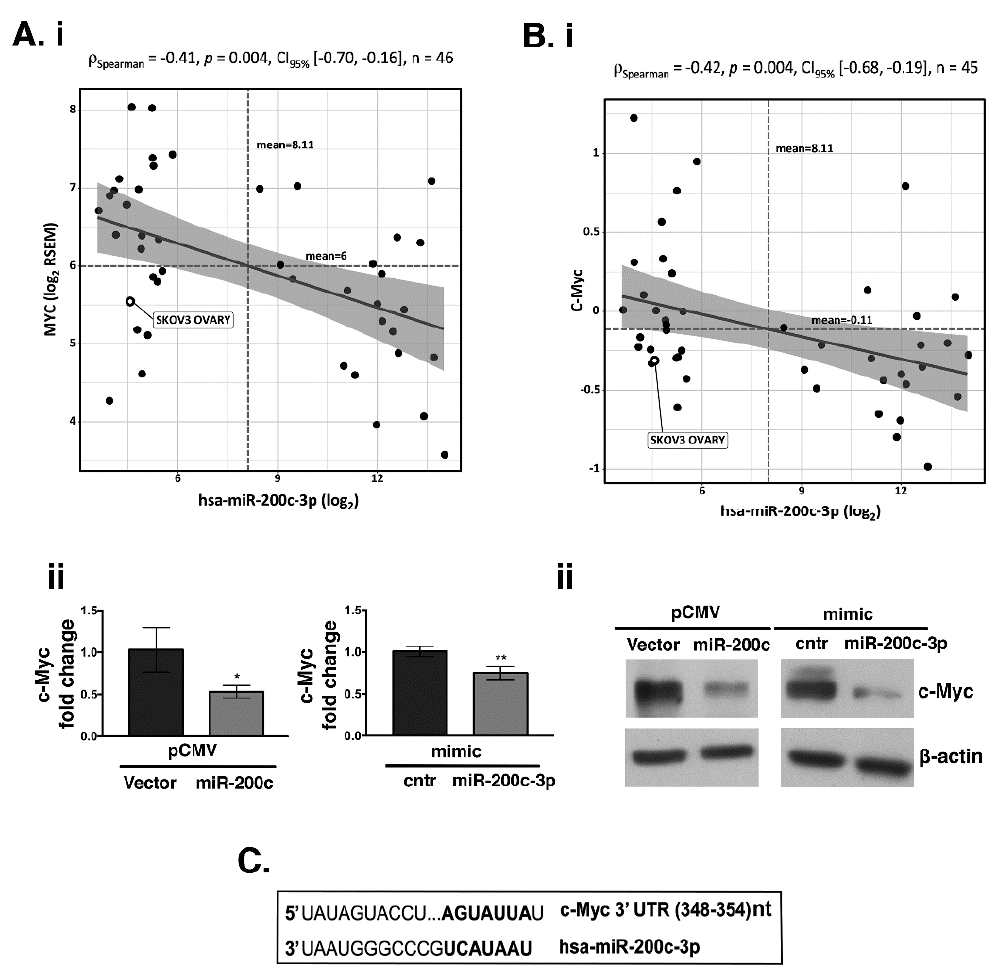
Figure 3. Transcriptional and translational regulation of c-Myc by miR-200c-3p ( A ) ( i ): RNA-sequencing data retrieved from CCLE data portal of 46 cell lines showed an inverse correlation between MYC gene and miR-200c-3p. ( ii ): RT-qPCR was used to verify the decrease of c-Myc transcript in both, stably transfected (pCMV V. and miR-200c) and transiently transfected (mimic cntr and mimic miR-200c-3p). SD ± shows the mean of three independent experiments and in technical triplicates. * p < 0.05, ** p < 0.01, ( B ) ( i ): Reverse Phase Protein Arrays (RPPA) extracted from CCLE data portal in 45 OC cell lines as in A, showed that c-Myc protein is inversely correlated with miR-200c-3p. Spearman correlation analysis was reported, with statistical significance ( p < 0.05). Confidence intervals at 95% are also reported. ( ii ): WB analysis of c-Myc expression in stably transfected (pCMV V. and miR-200c) and transiently transfected (mimic control: cntr and mimic miR-200c-3p). ( C ): TargetScan v7.1 prediction shows a miR-200c-3p binding site (seed sequence) in the 3 ′ UTR of c-Myc from 358 to 354 nucleotides (top).